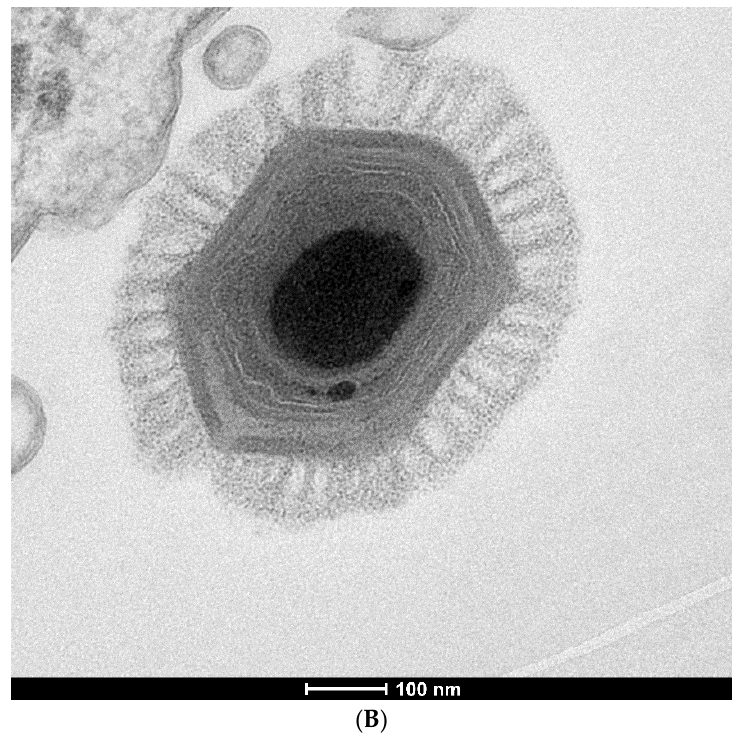
Figure 2. Transmission electron micrographs of giant virus particles. ( A ) Pithovirus , as seen in Michel et al. [22]. Originally identified as a KC5/2 parasite, the image shows the electron dense viral wall consisting of perpendicularly oriented fibers or microtubules (arrows), and a marked ostiole (os) located at the apical end of the cell. Reprinted with permission—original magnification at 85,000×; ( B ) Megavirus chilensis . Image courtesy of Professors Chantal Abergel and Jean ‐ Michel Claverie.